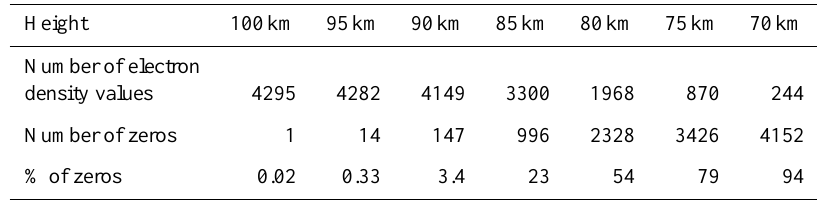
Table 3. Spread of values in terms of median and quartiles Height 100km 95km 90km 85km 80km Median Lower quartile